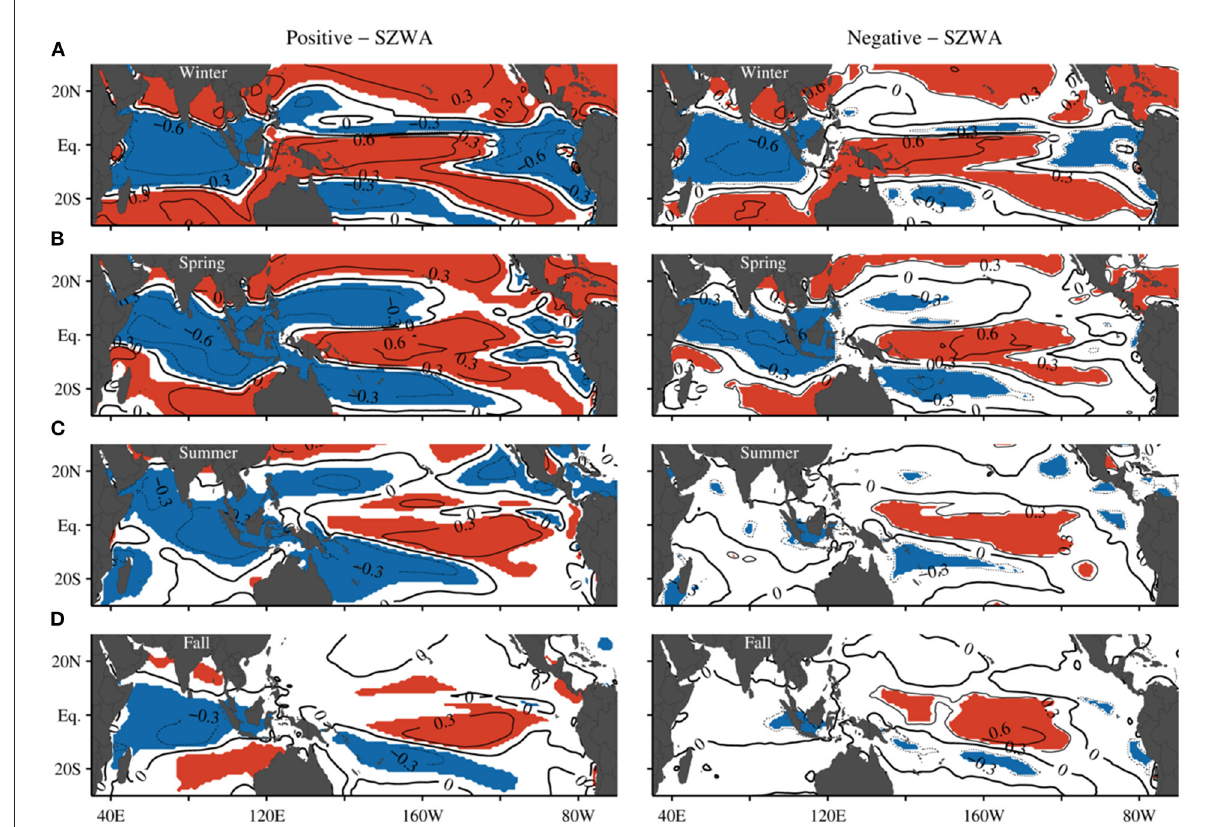
FIGURE14 Comparison of lag correlations between the SZWA over the far western equatorial Pacific in fall and the tropical Indo-Pacific SZWA in the following four seasons during the positive (left column) and negative (right column) phases of the decadal variability in the CCSM4 historical simulations. (A) Winter (December to February). (B) Spring (March to May). (C) Summer (June to August). (D) Autumn (September to November). The contour interval is 0.3. Red and blue shades indicate 99% confidence level of positive and negative correlation,